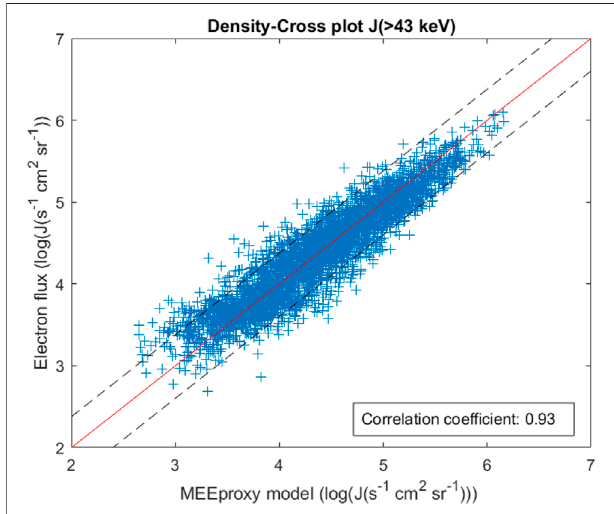
FIGURE 7 | Scatter plot of a linear fi t of the logarithmic value of the optimized MEE proxy and logarithmic value of the daily > 43 keV fl uxes. The black, dashed lines show the 95 and 5 percentile of the model